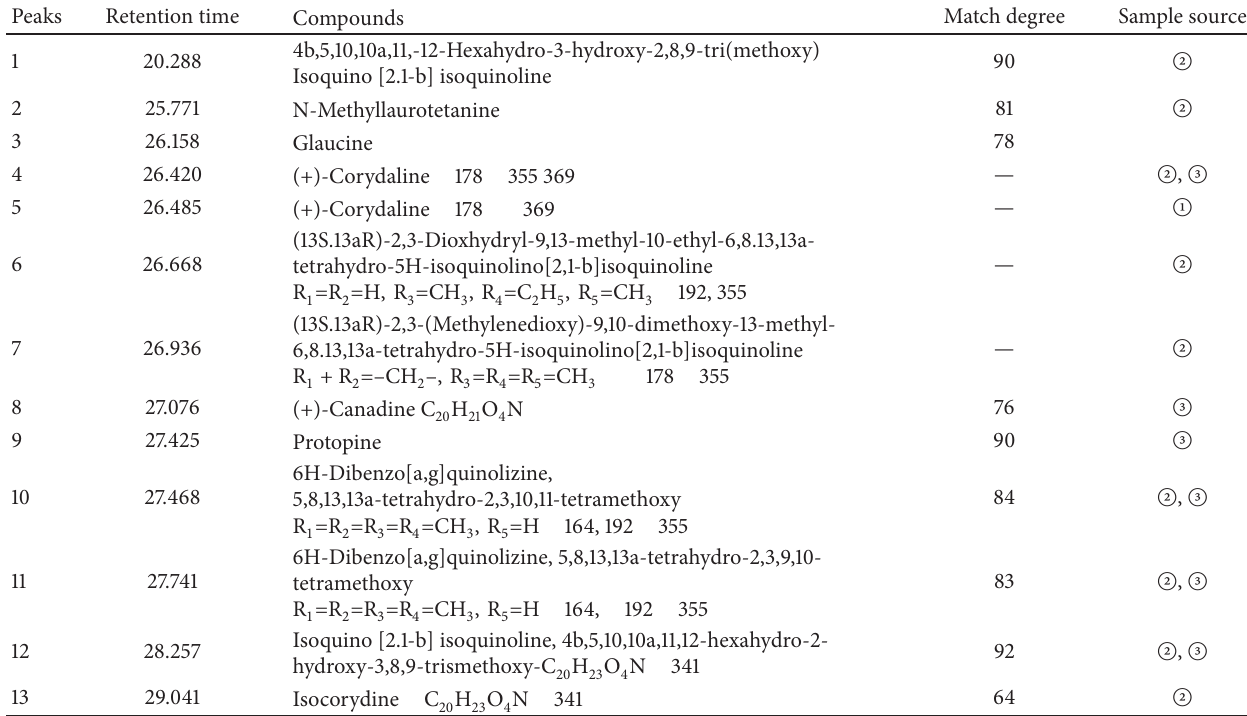
Table 1: Alkaloids identified from processed RC and RC by mass